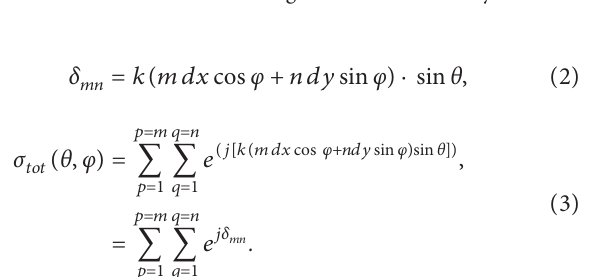
Figure 1: Schematic diagram of antenna